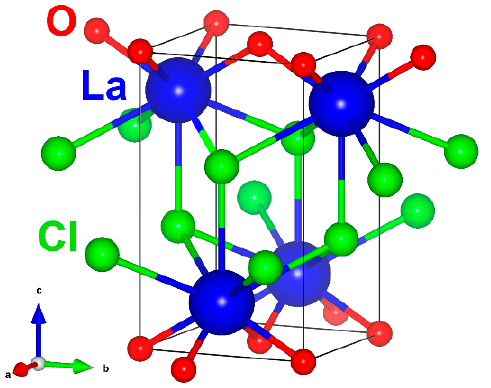
Figure 1. Crystal structure of LaOCl. Visualized in VESTA [49] using atom coordinates from [45].